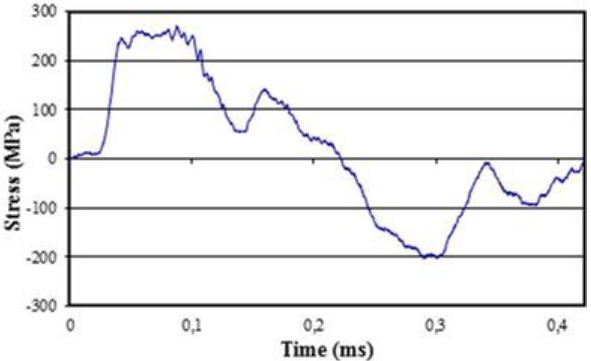
Figure 18. Incident and reflected stress waves relating to the mod- ified SHTB without the interruption fixture (Model 2) at a pressure equal to